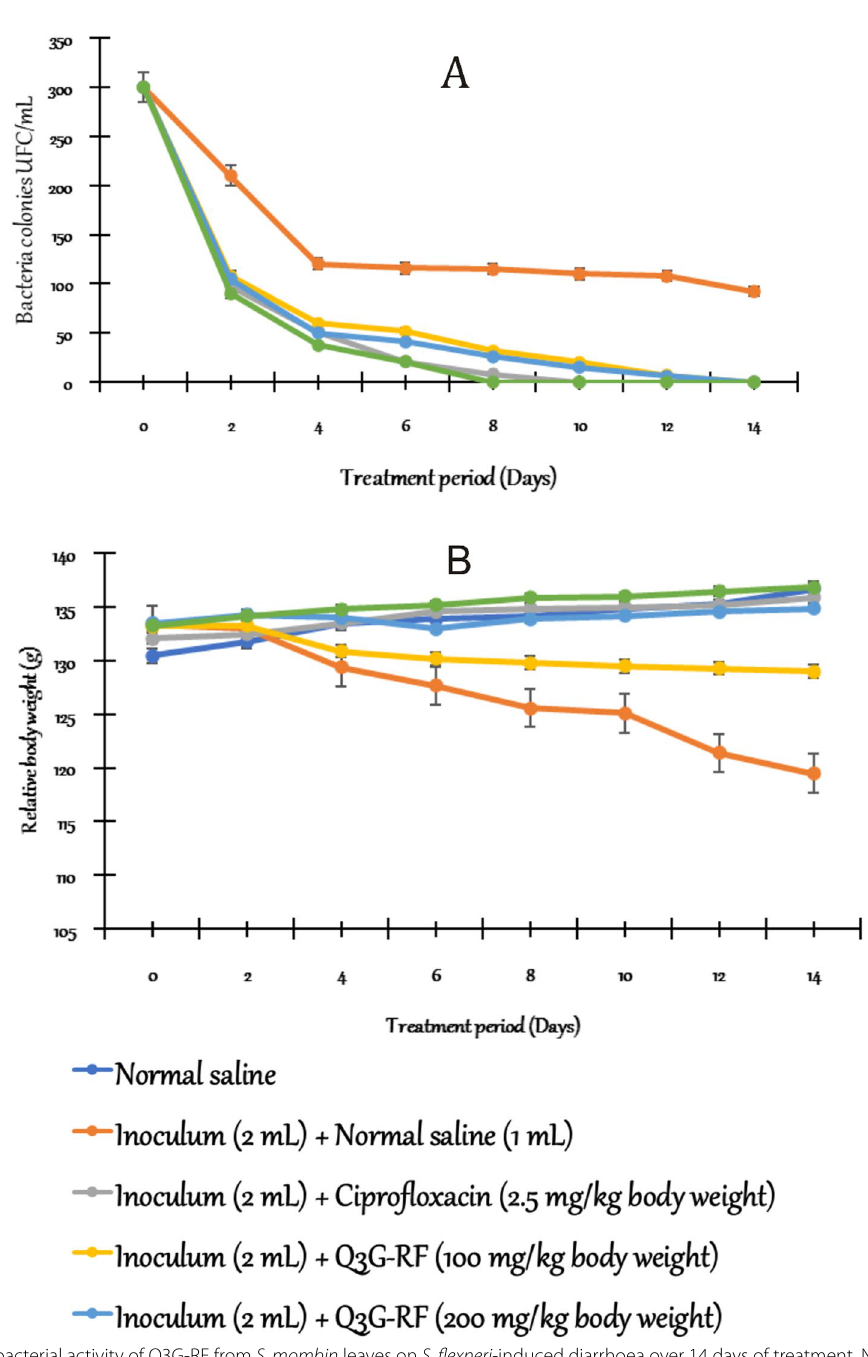
Fig. 1 In vivo antibacterial activity of Q3G-RF from S. mombin leaves on S. flexneri -induced diarrhoea over 14 days of treatment. Number of Shigella flexneri in stool ( A ) and variation of the relative body weight ( B ) of male Wistar rats treated with normal saline, inoculum (2 mL) normal saline (1 + mL), inoculum (2 mL) ciprofloxacin (2.5 mg/kg body weight), inoculum (2 mL) Q3G-RF (100 mg/kg body weight), inoculum (2 mL) Q3G-RF + + + (200 mg/kg body weight), and inoculum (2 mL) Q3G-RF (400 mg/kg body weight). Values are expressed as mean standard error of mean ( n + ± = 6). Significant differences from the sham control group are indicated by † and from negative control by #, p <